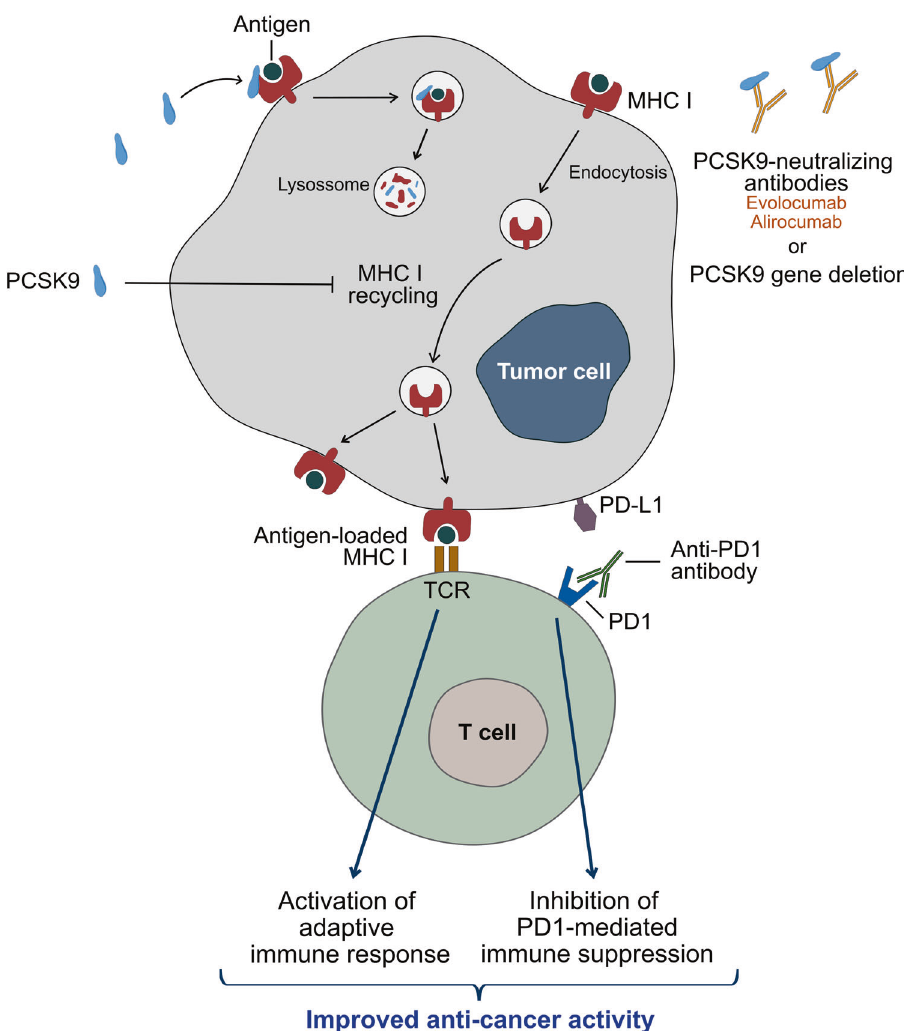
Fig. 1 Blockage of PCSK9 with the antibodies Evolocumab and Alirocumab or PCSK9 gene deletion enable the recycling of MHC I to the tumor cell surface improving the ef fi cacy of immune checkpoint